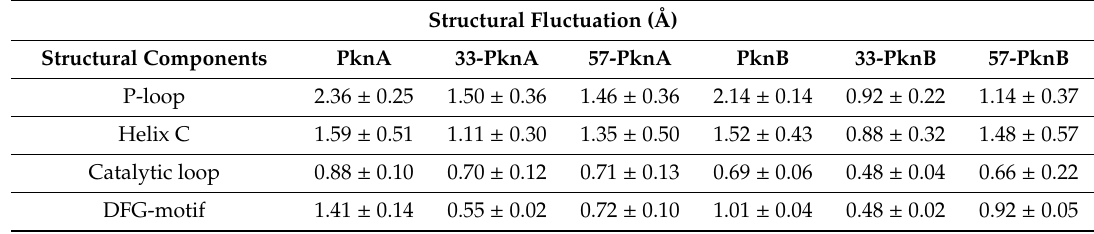
Table 2. RMSF analysis of structural components of the PknA and PknB NBPs in the presence of compounds 33 and 57